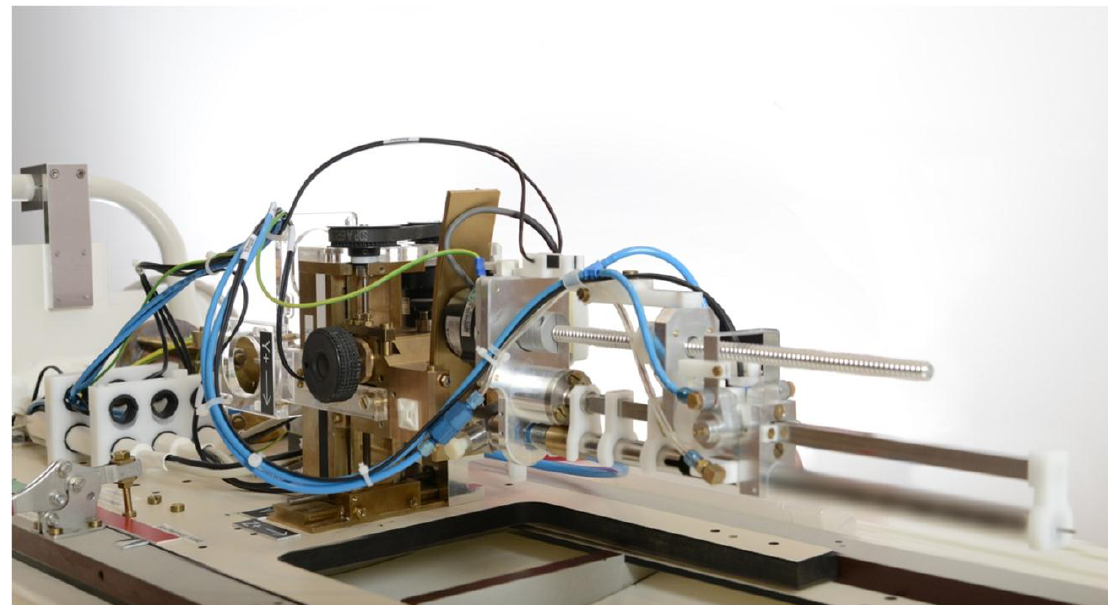
Figure 3. Magnetic resonance imaging (MRI)-compatible robotic implantation device for prostate brachytherapy. A cylindrical weight that is pneumatically driven hits the needle holder to tap a brachytherapy needle into the prostate. When placed between the patient’s legs inside an MRI scanner, the needle can be tracked using live images.